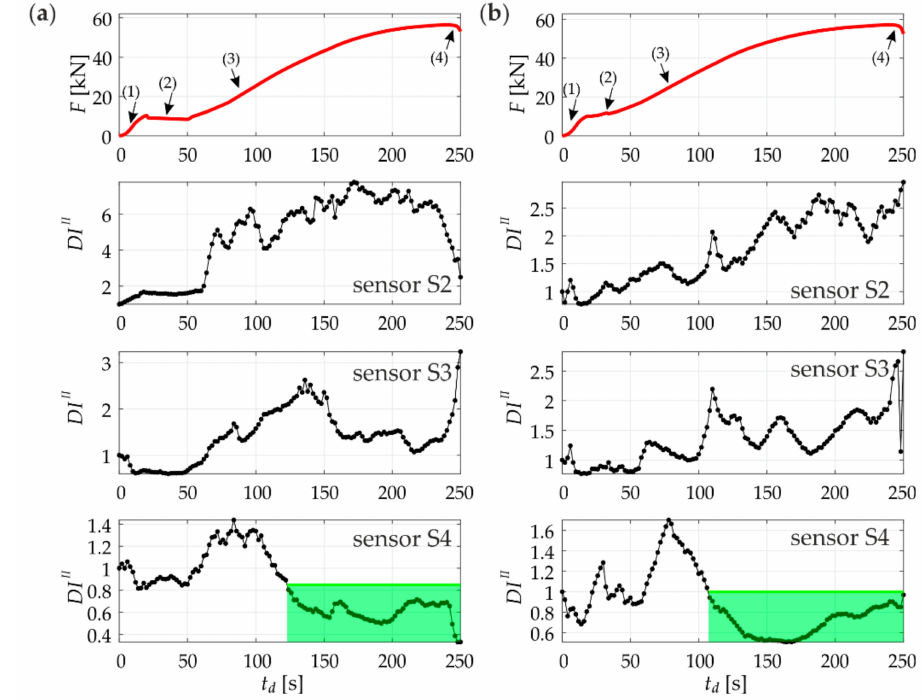
Figure 10. Damage index DI II for guided waves registered by sensors S2, S3, and S4 during tensile testing: ( a ) specimen #1; and ( b ) specimen